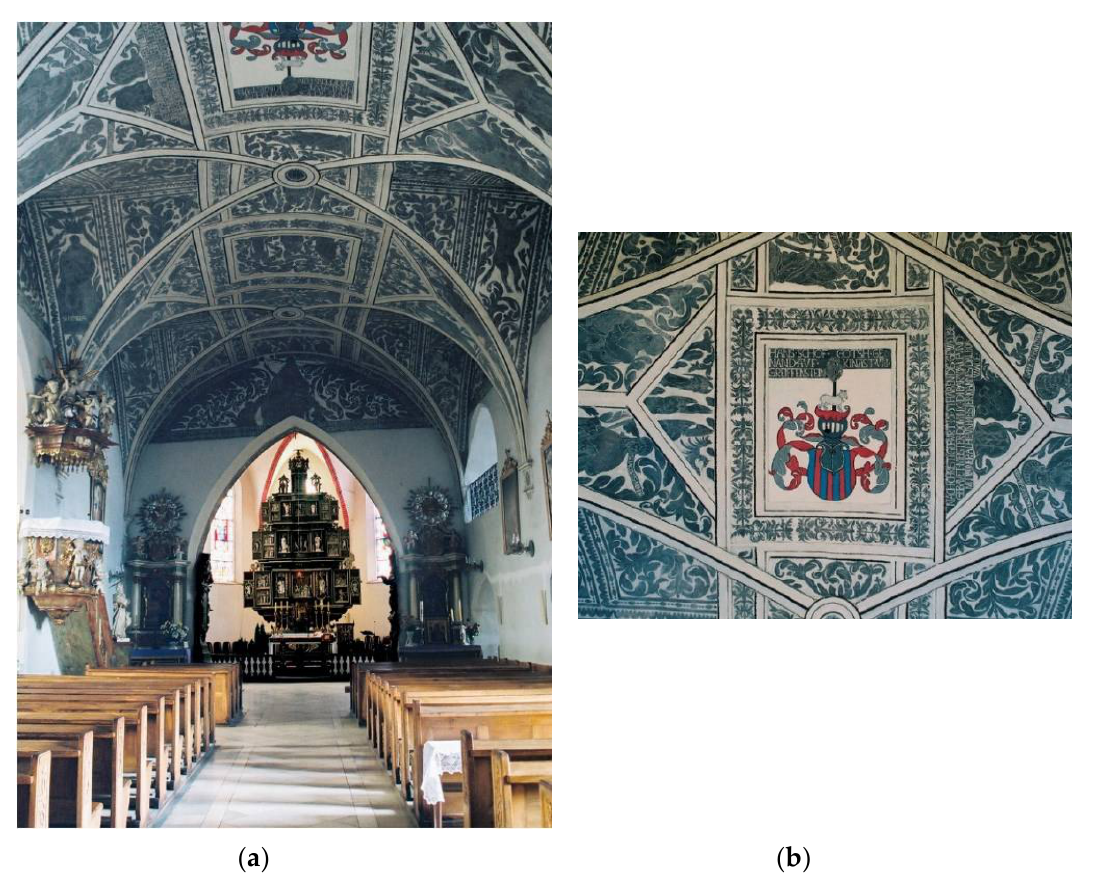
Figure 6. ( a , b ) Sgraffito decorations in the interior of the church in Gryfów. Author’s photo, 2013.